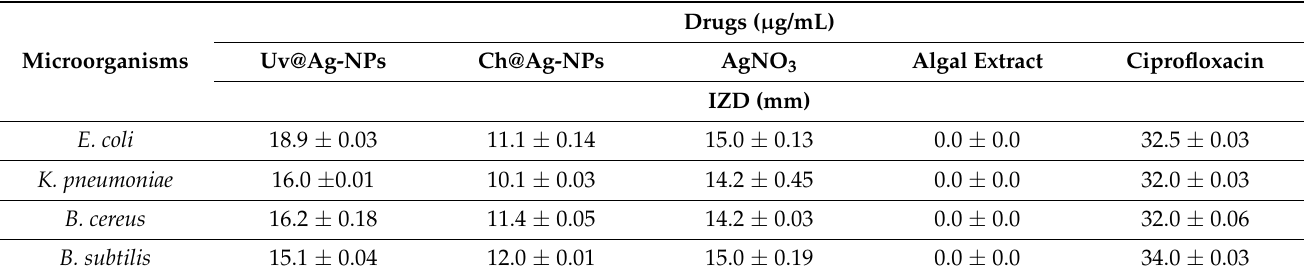
Table 3. Inhibition zones of 1 mg/mL of Uv@Ag-NPs, Ch@Ag-NPs, AgNO 3 , algal extract, and ciprofloxacin for E. coli , K. pneumoniae , B. cereus , and B. subtilis